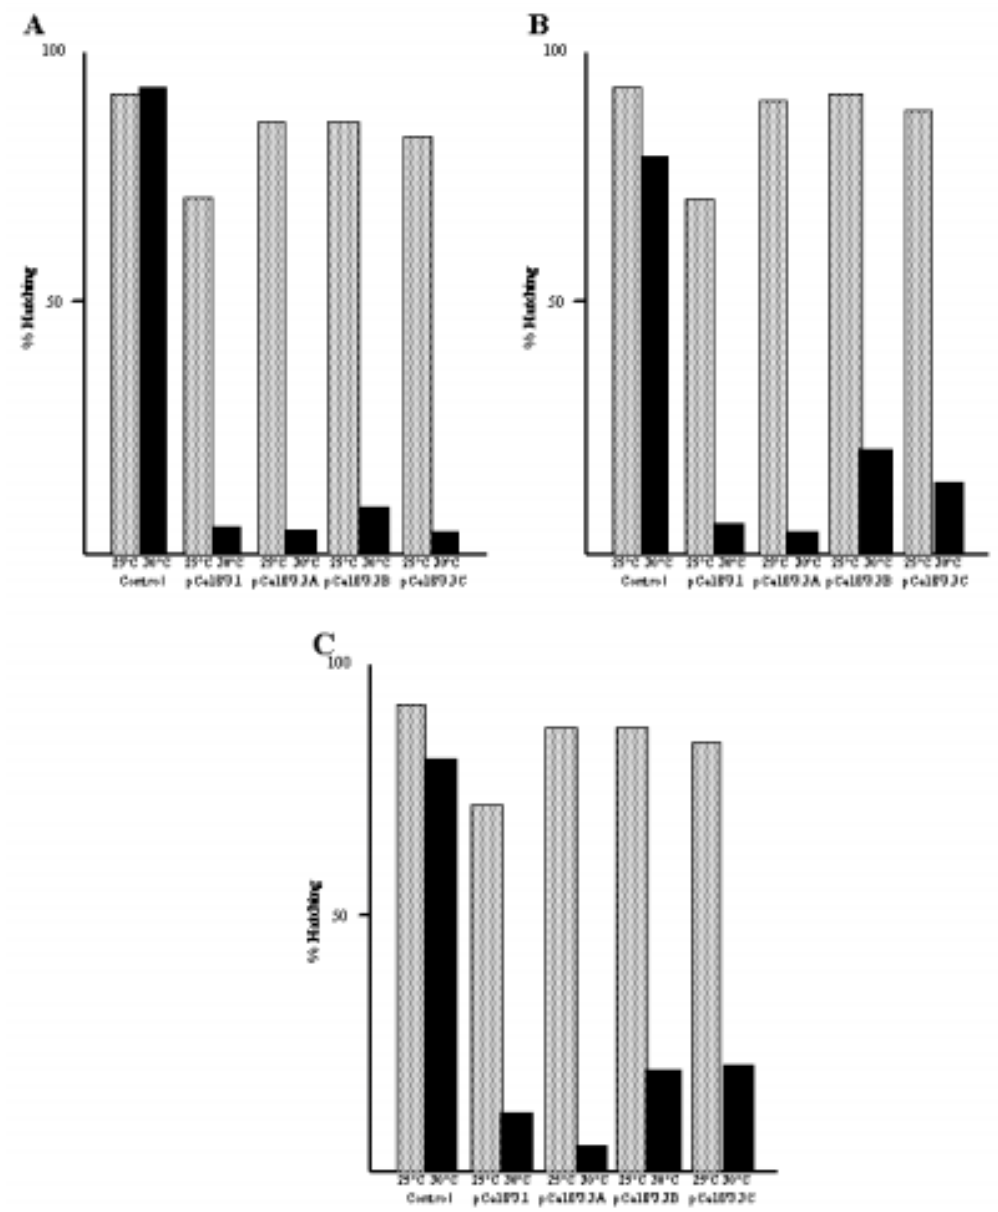
Fig. 3–EffectofthelengthoftheheatshockpulseinviabilityofembriosfromthefourpCa18 (cid:5) 3.1transgenic lines. 0-1h old embryos were heat shocked for 2hs in (A), 4hs in (B) and 6hs in